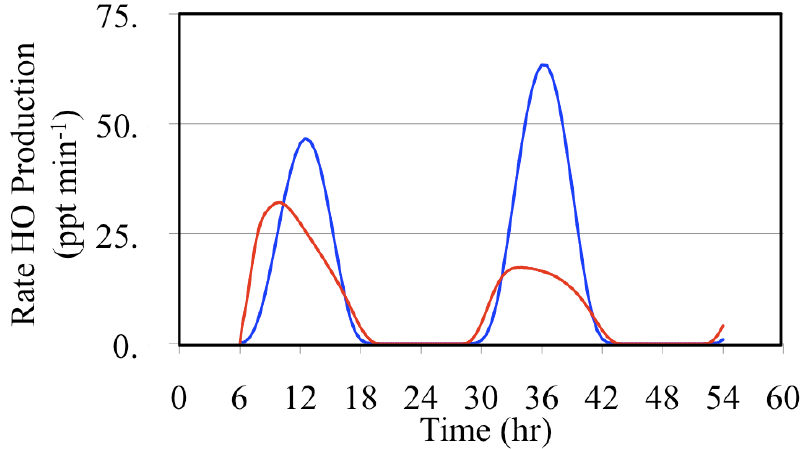
Figure 17. Production rates of HO • initiated through the photolysis of formaldehyde (red line) and the photolysis of O (blue line) are shown for the polluted urban atmosphere case. 3